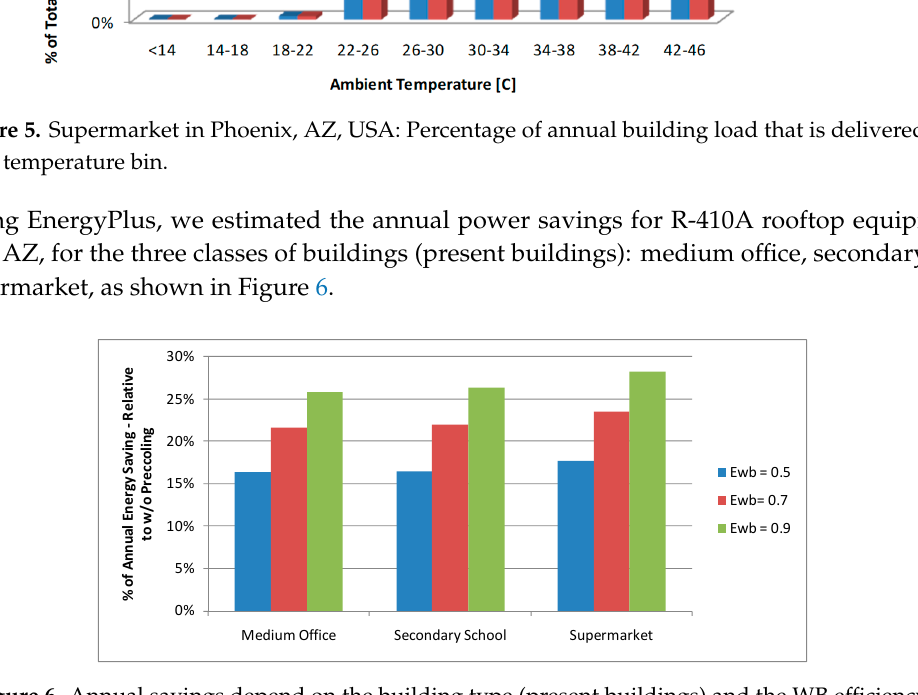
Figure 6. Annual savings depend on the building type (present buildings) and the WB efficiency.